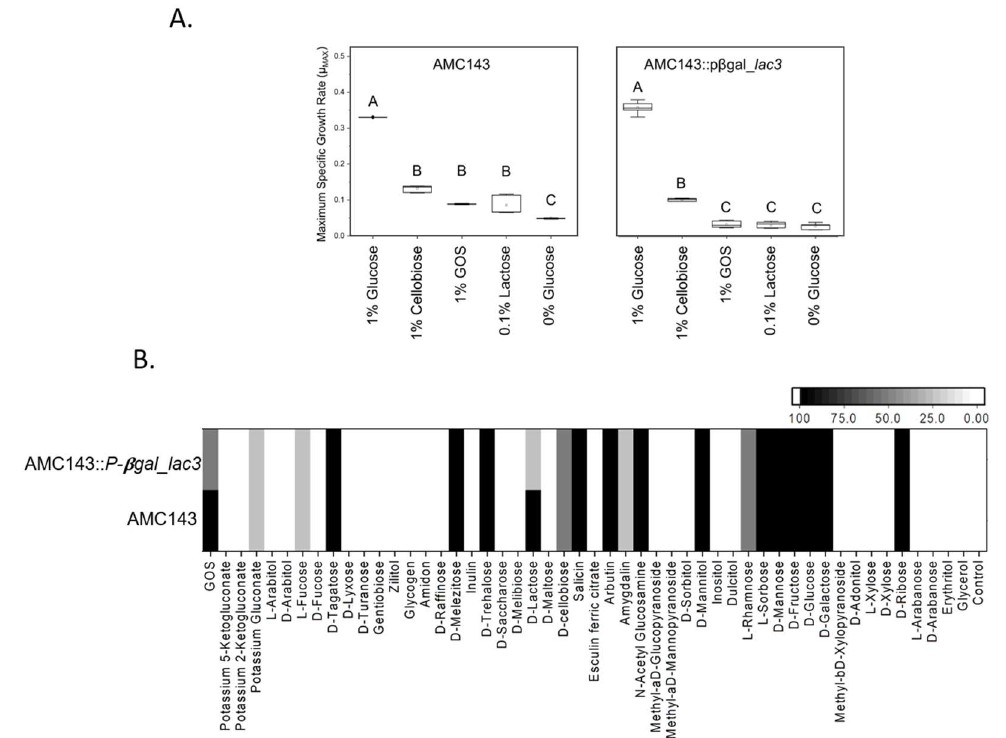
Figure 6. Growth and fermentation profiles of AMC143:: pβgal_lac3 . ( A ) Maximum specific growth rates for AMC143 and AMC143:: βgal_lac3 were determined in MRS containing 1% glucose, 1% GOS, 0.1% lactose, 1% cellobiose, and 0% glucose. Letters represent statistical differences between strain culture in each media type ( n = 8, p < 0.05). ( B ) Carbohydrate utilization profiles were generated by API 50CH, revealing that the mutant was unable to ferment GOS and lactose after 24 h.